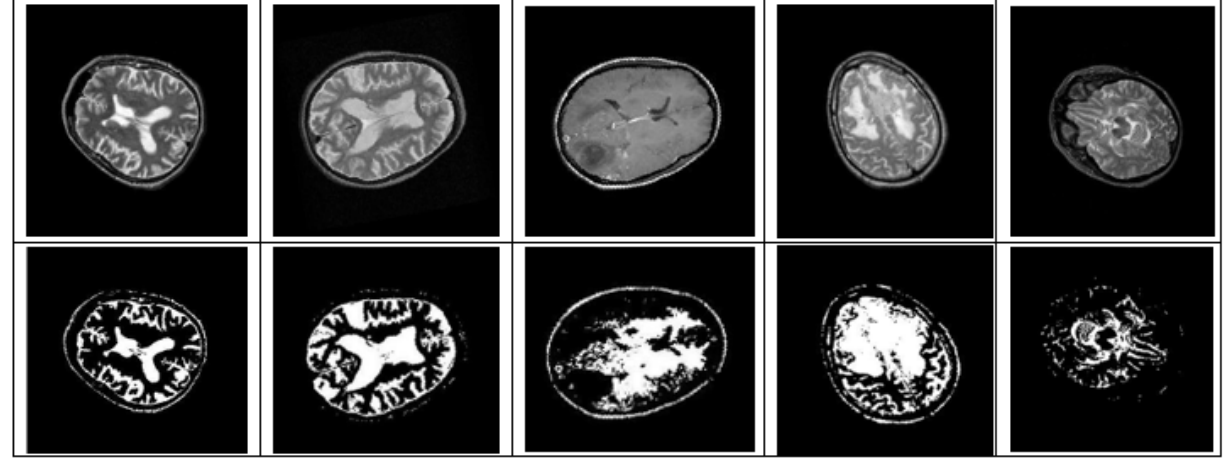
Figure 5. Here, image ( a ) is an input distorted/simulated (rotated and scaled) brain MRI image and image ( b ) is a segmented simulated (rotated and scaled) image. A segmented image classifies it as a Malignant Tumor.